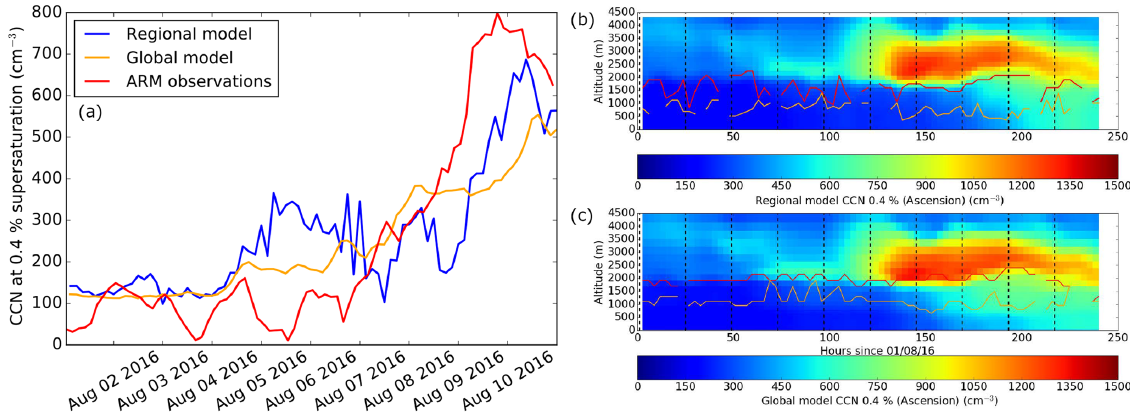
Figure 6. (a) CCN at 0.4% at Ascension at the surface measured with the ARM CCN counter (Holdridge et al., 2016a) and compared to our simulations, and (b) the vertical profiles of CCN in the global and regional models, averaged over the domain. The loud top and cloud base heights at Ascension Island itself are marked in red and orange respectively. The black dotted lines indicate midnight, local